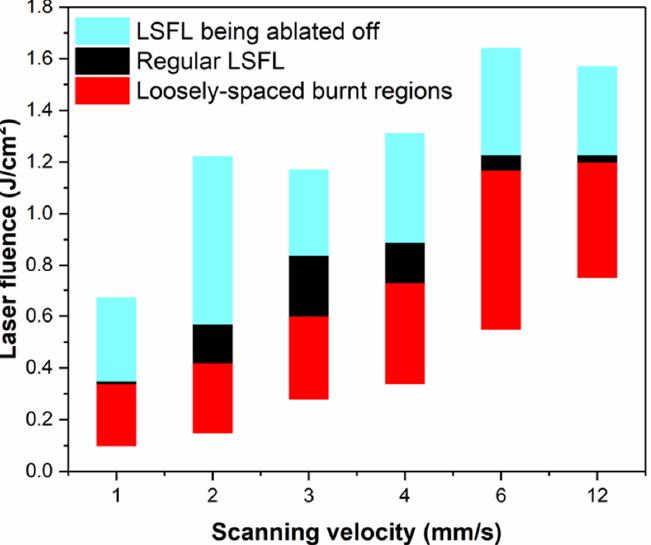
Figure 12. Different types of micro/nanostructures depending on the laser fluence and scanning velocity.